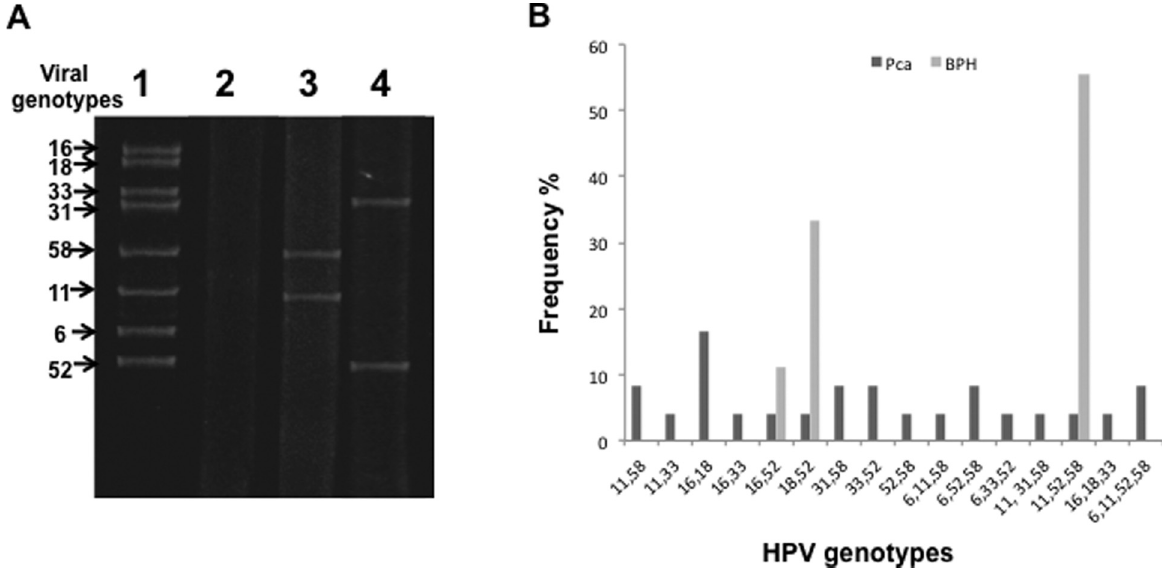
Figure 1 - HPV genotypes detected in this study. (A) Electrophoresis of PCR products. Lane 1: positive control (HPV genotypes detected), lane 2: nega- tive control (no added DNA), lanes 3 and 4: representative samples. (B) HPV genotypes frequency in biological samples analyzed.